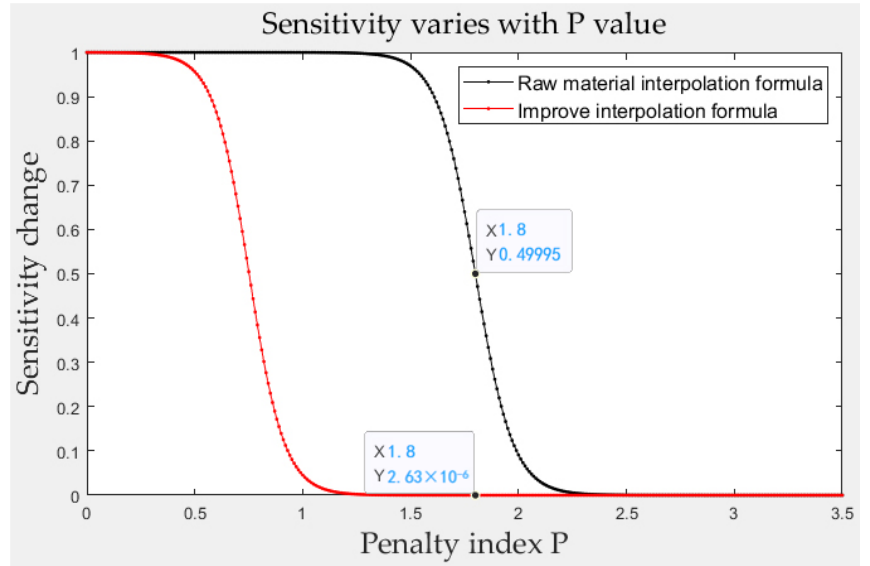
Figure 1. The variation in sensitivity with the penalty index p before the improvement in the material interpolation method formula (black) and after improvement (red).